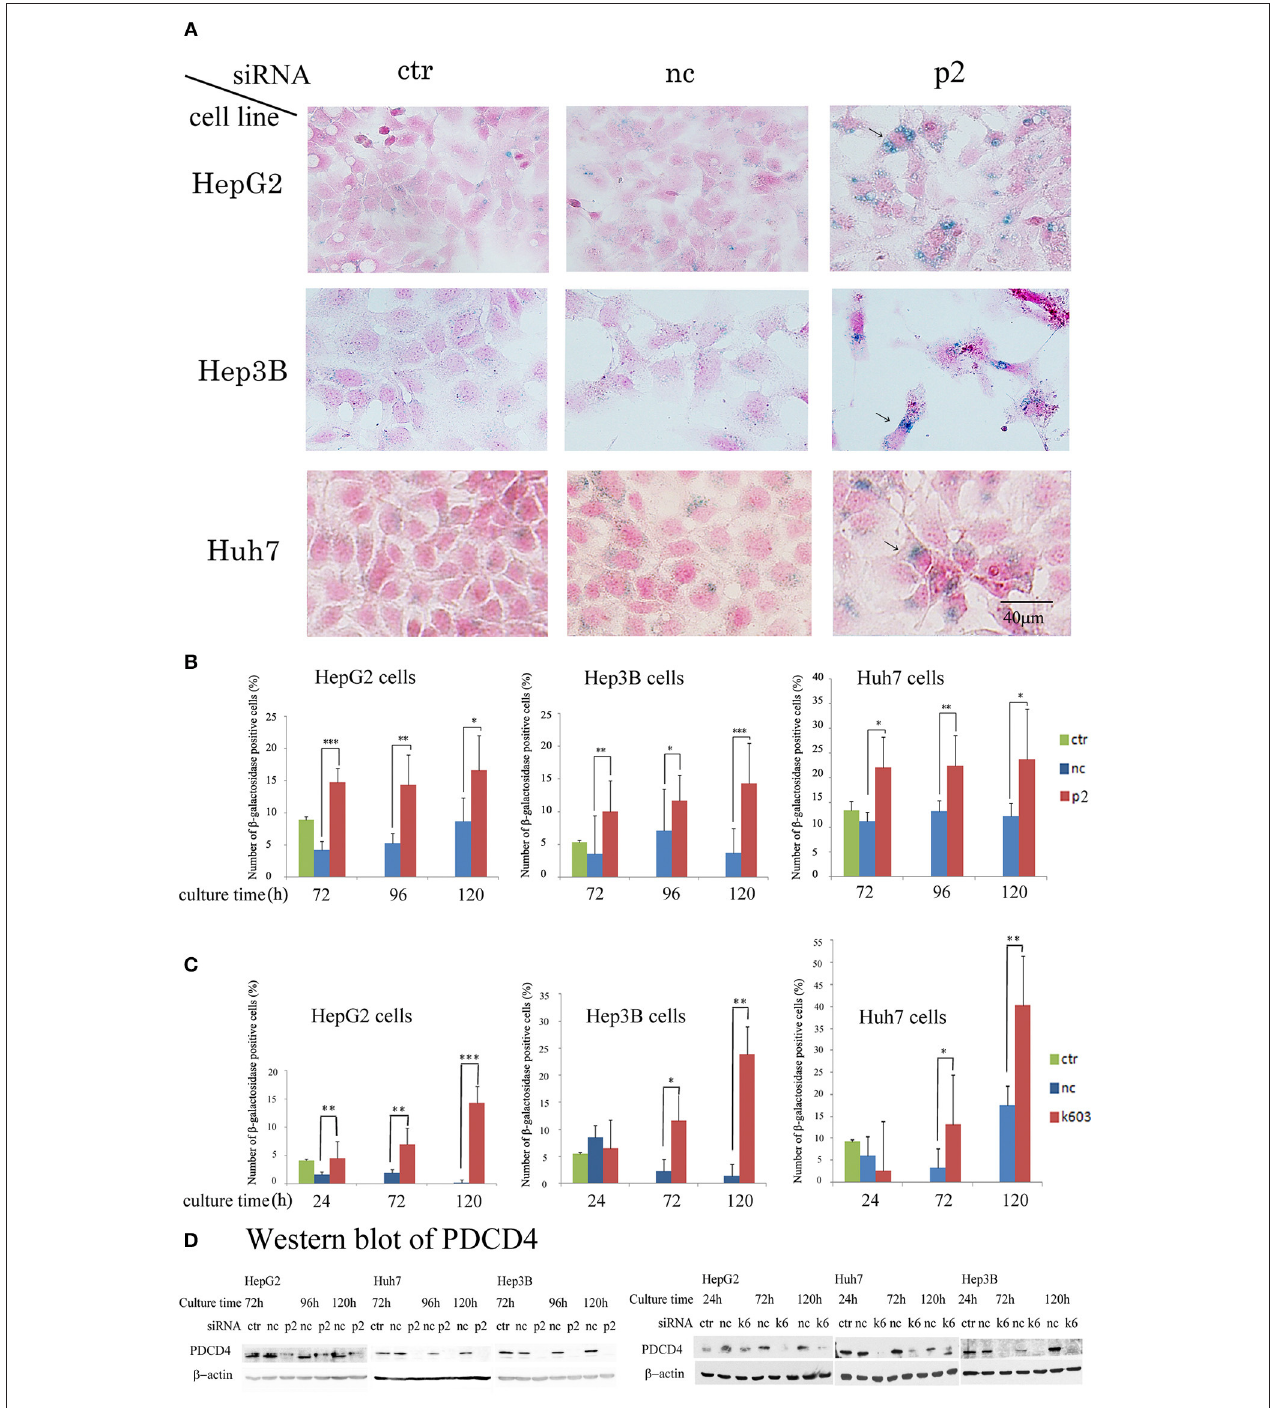
FIGURE 7 | PDCD4 knockdown induced replicative senescence. (A) β -galactosidase staining patterns in the untreated control cells (ctr), negative control siRNA-treated cells (nc), and PDCD4-specific p2 siRNA-treated cells (p2) in HepG2, Hep3B, and Huh7 cells at 4 day of culture after the siRNA treatments. The cells with arrows are enlarged and show morphological changes and β -galactosidase positivity. (B) The number of β -galactosidase-positive HepG2, Hep3B, and Huh7 cells after PDCD4 knockdown with p2 siRNA (p2), treatment with negative control siRNA (nc) and no treatment (ctr). (C) The number of β -galactosidase-positive HepG2, Hep3B, and Huh7 cells after PDCD4 knockdown with k603 siRNA (k603), treatment with negative control siRNA (nc) and no treatment (ctr). The data represent the average cell number of three different fields, and thousands of cells were counted in each field. These experiments were repeated independently three times, and similar results were obtained each time. A representative result from the experiments is shown in this figure. t -test: * p < 0.05; ** p < 0.005; and *** p < 0.0005. (D) PDCD4 levels analyzed by Western blot in PDCD4 knockdown cells.